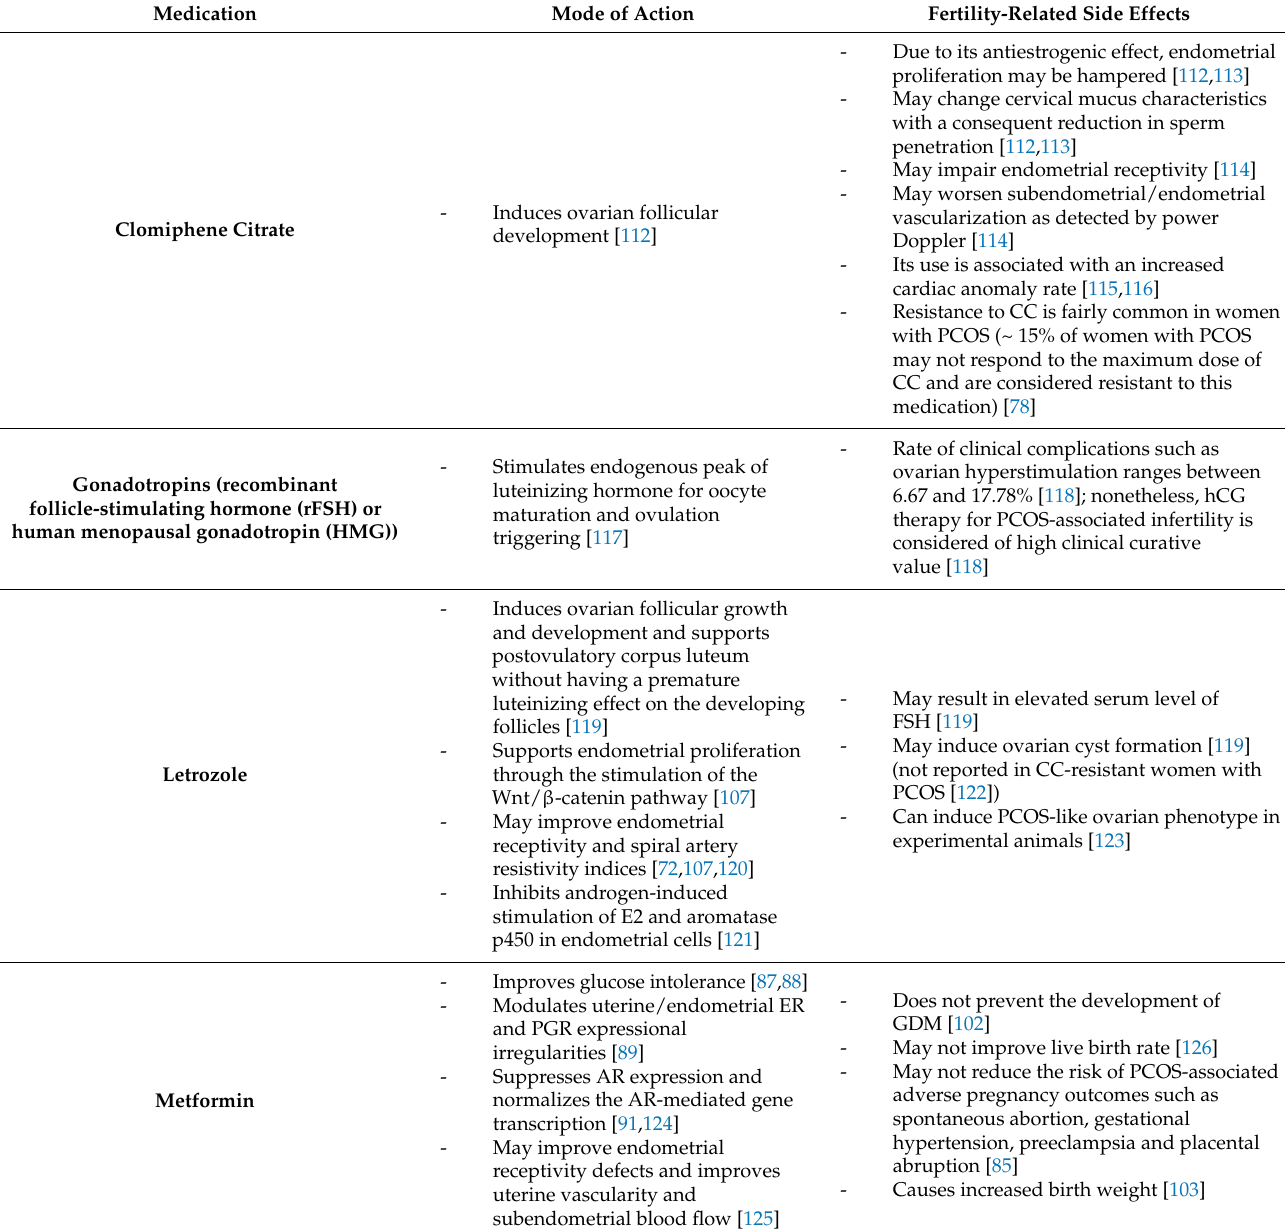
Table 2. Mode of action and fertility-related side effects of current pharmacological agents * commonly used in anovulatory women with